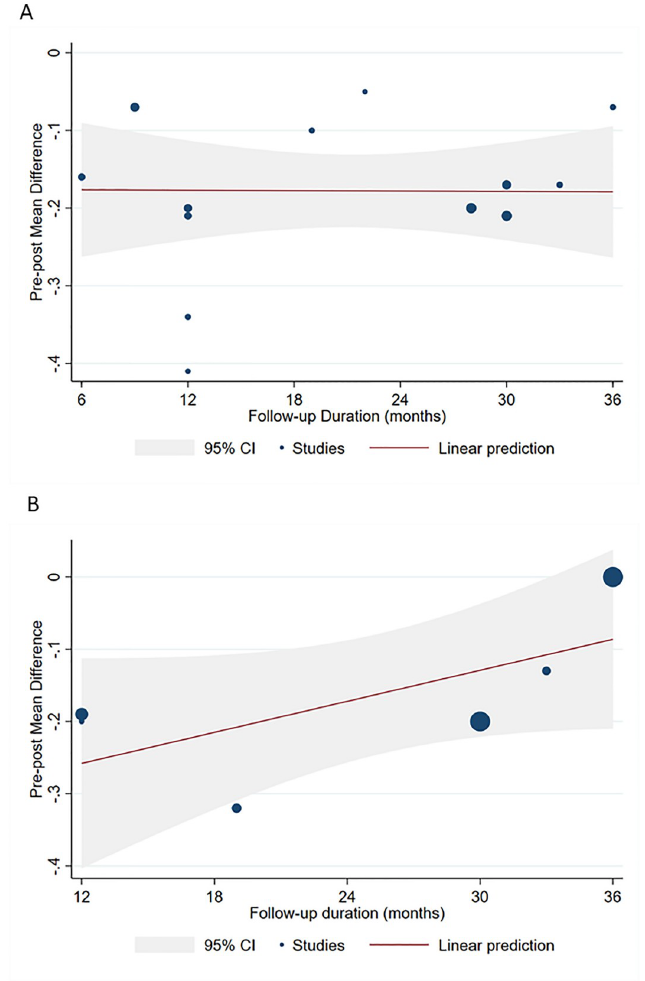
Fig 5. Meta-regression showing no significant effect of follow-up duration on pre-post mean difference in BCVA in the degenerative LMH and LHEP group (A) and in tractional LMHs